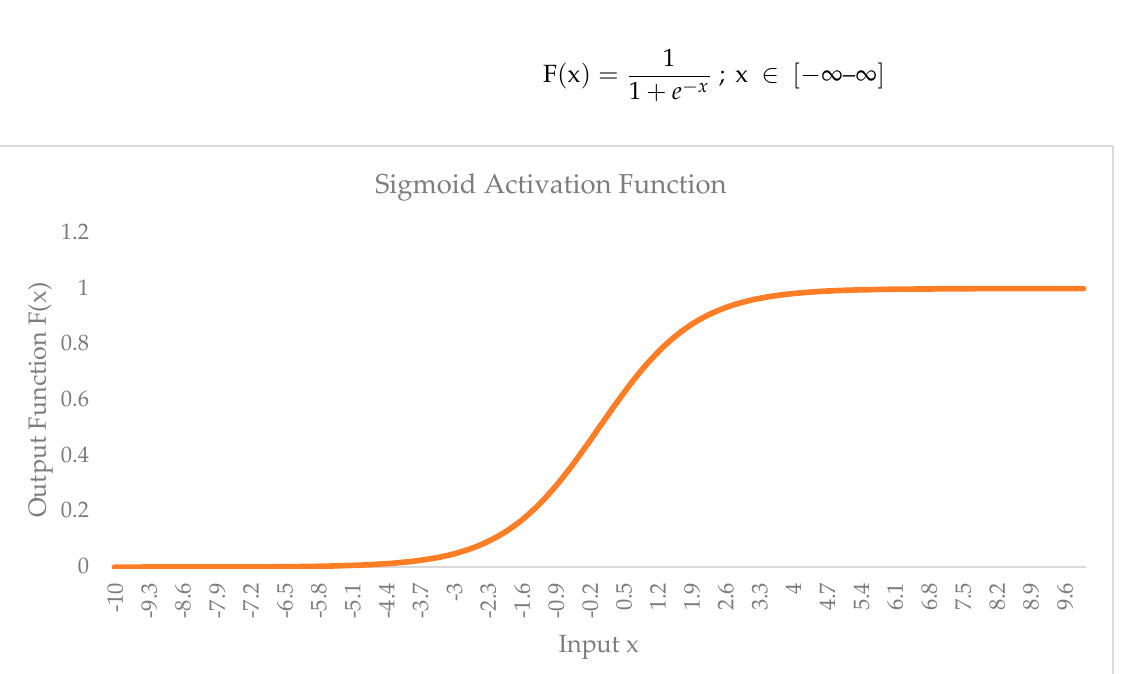
Figure 5. Graphical representation of the ReLU activation function.